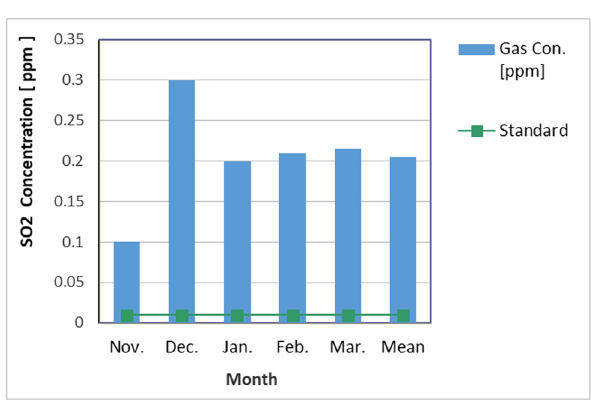
Figure 7: Monthly concentrations and overall mean of SO 2 gas during the study period.